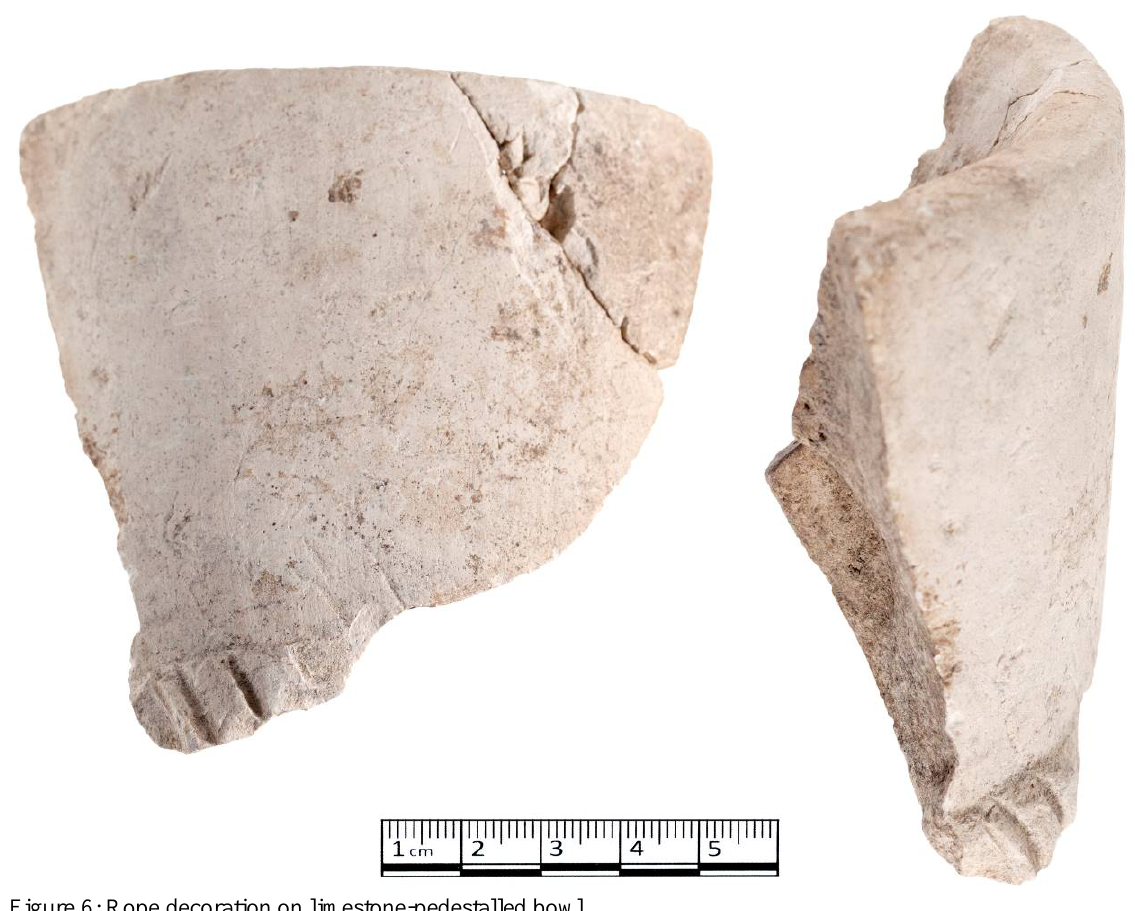
Figure 6: Rope decoration on limestone-pedestalled bowl.